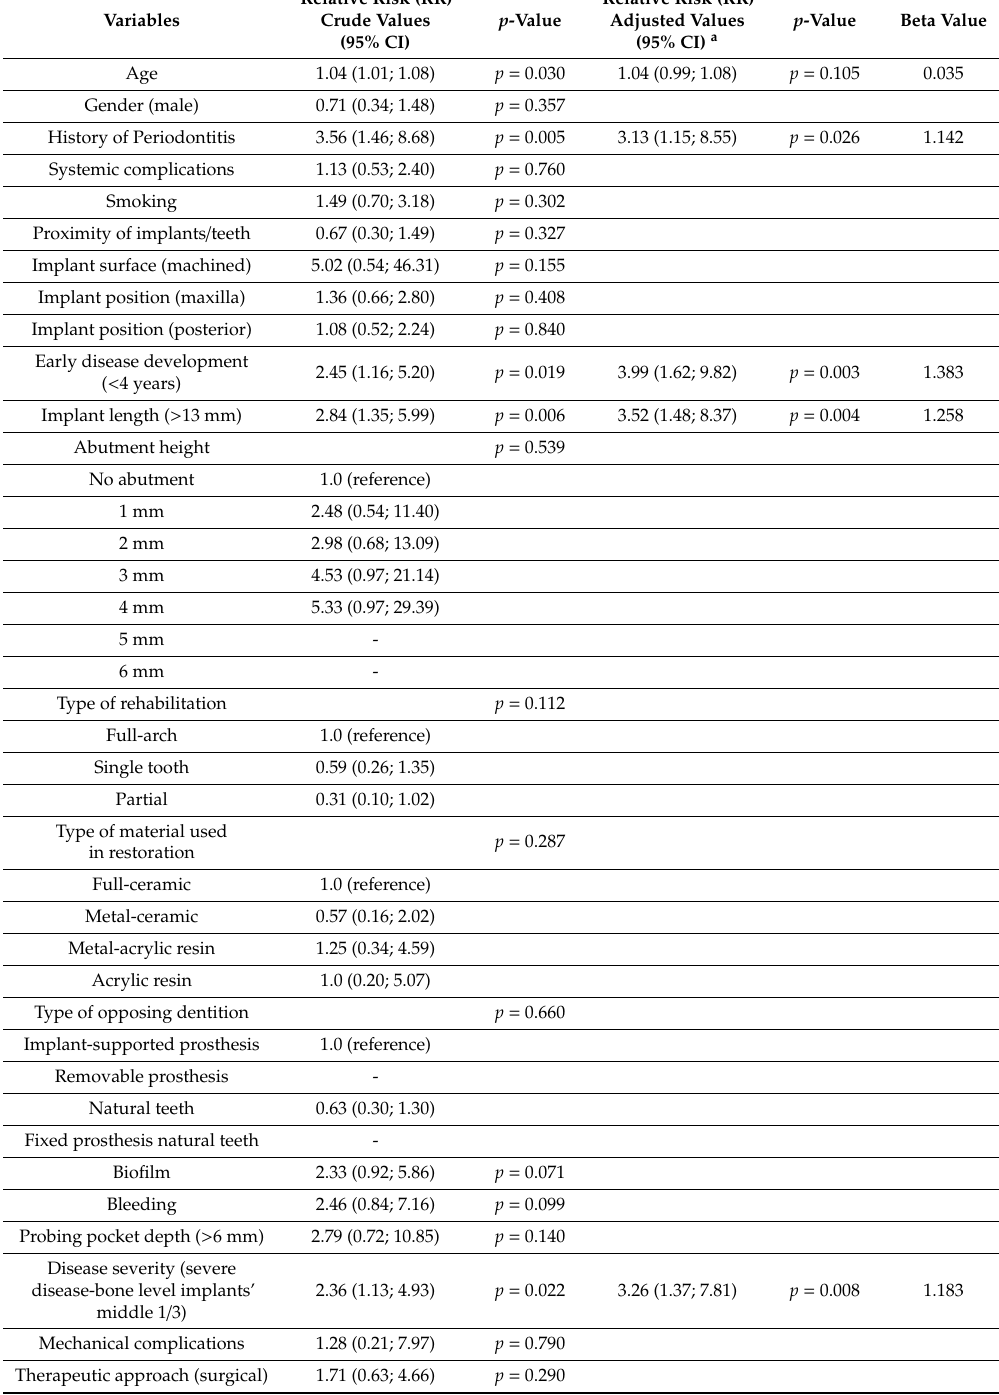
Table 2. Univariable and multivariable logistic regression analysis for bad prognosis of Peri-implant